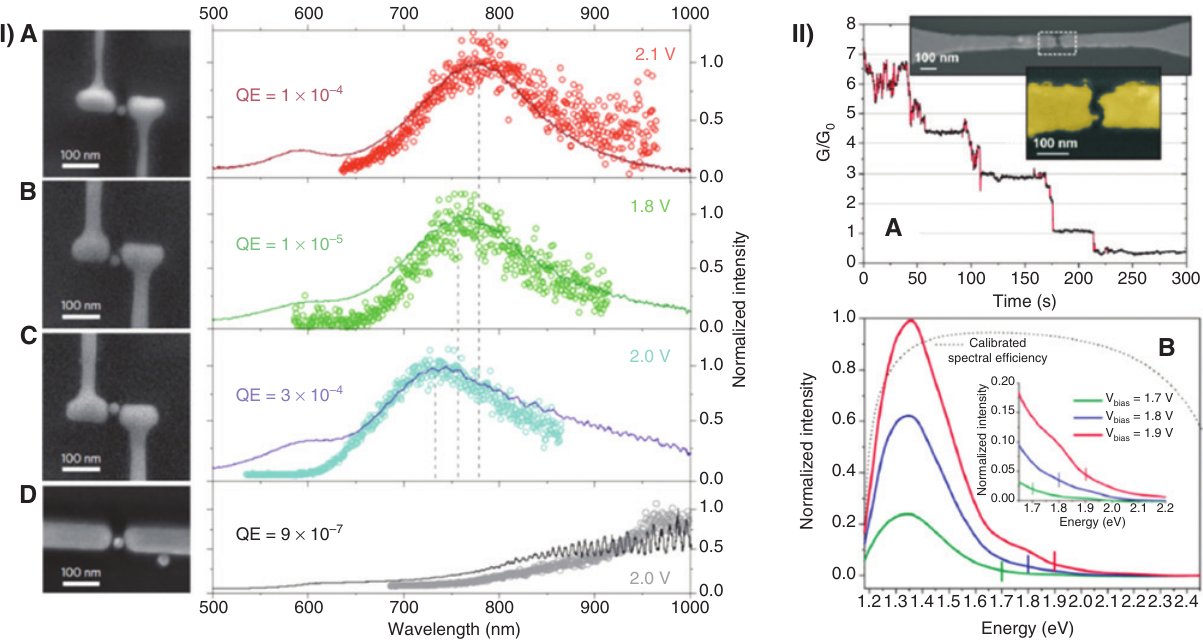
Figure 6: On-chip solutions for planar tunneling junctions. I. Electroluminescence (open circles) and scattering spectra (solid lines) for different antenna geometries (A–C) and a non-resonant wire several micrometers long (D). The external QEs and applied voltages are stated. The left column shows electron micrographs of the corresponding structures reprinted with permission from Ref. [31] copyright 2015 Springer Nature. II(A). Normalized conductance during the last moments of the electromigration process showing quantum conductance steps. Inset: Scanning electron micrograph of an Au nanowire after electromigration and close-up view of the junction area. (B) Emission spectra showing the shift with the applied bias. The vertical bars indicate the quantum limit. Inset: Magnified energy distributions near the quantum limit, reprinted with permission from Ref. [30], copyright (2015) American Chemical